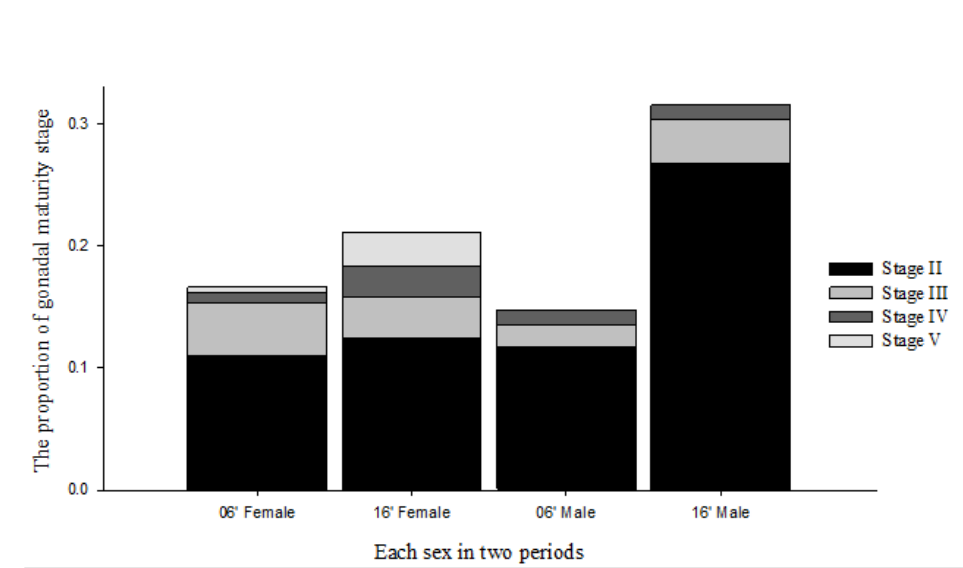
Figure 4. Proportion of gonadal maturity in females and males of Johnius belengerii in 2006 and